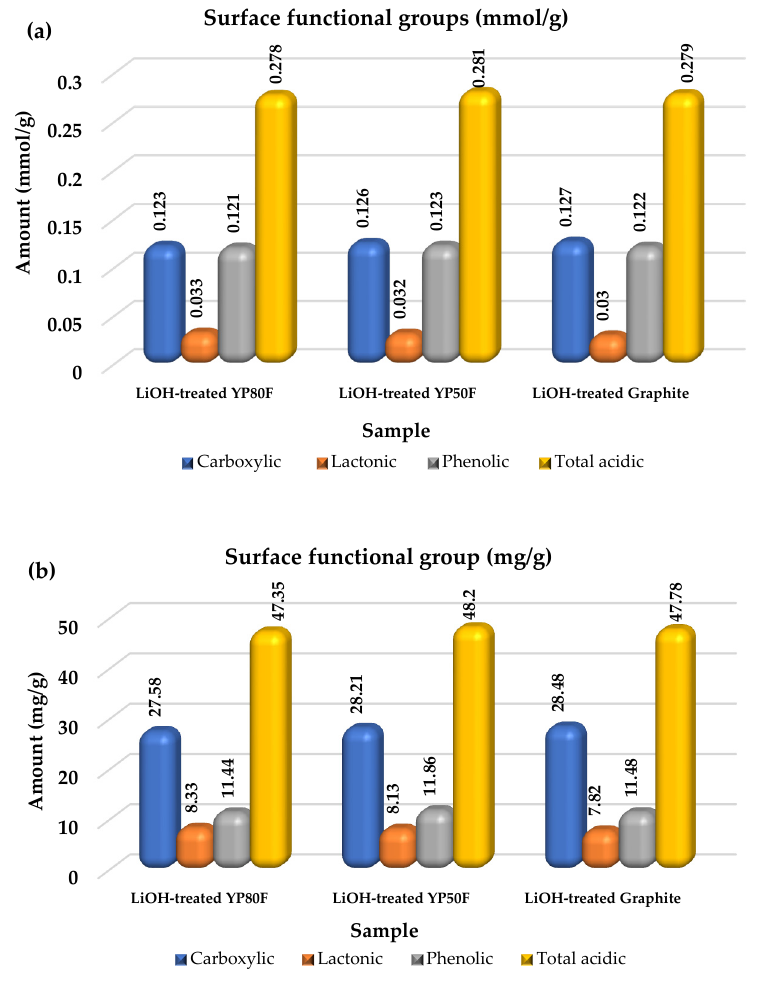
Figure 4. Boehm titration result of LiOH-treated YP80F, YP50F and graphite. ( a ) mmol/g unit, and ( b ) mg/g unit.